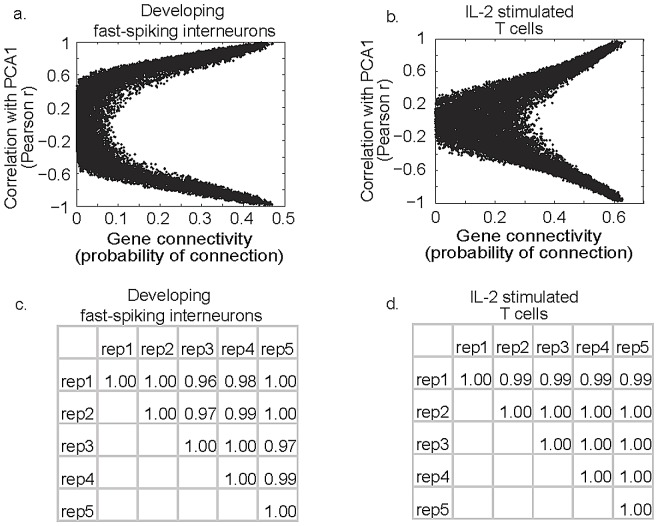
Connectivity of genes relates to how well genes follow gene expression programs.Gene connectivity was calculated as the number of genes that had significant covariance with a gene over the total number of genes. Connectivity (x-axis) was compared to a gene's Pearson r value for its correlation with program status (PCA1). Panels (3a & 3b) demonstrate that the most connected genes have the highest absolute Pearson r values indicating that highly connected genes follow more closely with programs than less connected genes. Panels (3c & 3d) are cross-correlation tables for PCA1 calculated using independent groups of 2000 probesets from the same transcriptomes. Tables show that PCA1 values are nearly identical even when completely different genes from the same transcriptomes are used for principal components analysis.